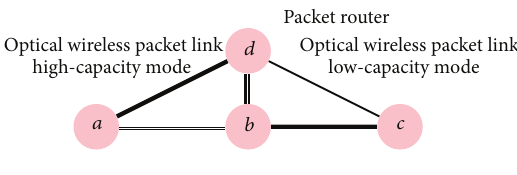
Figure 1: An optical wireless network.